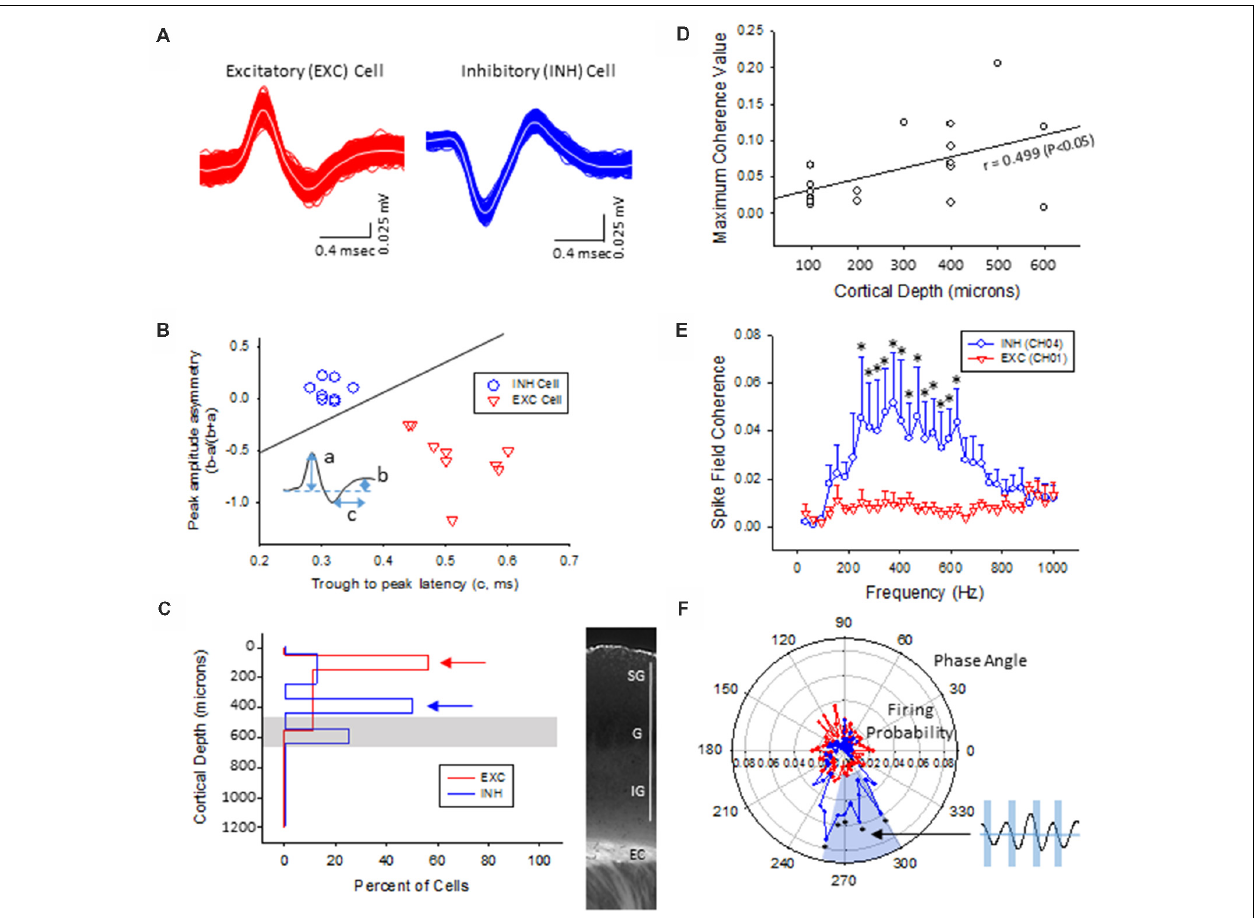
FIGURE 8 | Inhibitory cells from the lower supragranular layer were phase-locked to HFR oscillations in the malformed cortex of freeze lesion animals. (A) Spike sorting of a putative excitatory (red) and inhibitory (blue) cell, based on the associated waveform of each spike. White line in each trace represents the average of the multiple overlapping traces shown in color. (B) Three parameters were calculated from the average trace of each spike waveform (a–c as indicated from inset) to extract features used to classify neurons as either excitatory or inhibitory. Solid line represents the cutoff used to classify excitatory vs. inhibitory cells (Reyes-Puerta et al., 2016). (C) Distribution of isolated single-units across cortical depth. Value of 0 = cortical surface. Arrows indicate the cortical level that expressed the maximal number of excitatory vs. inhibitory neurons. Gray bar indicates level of the granular layer. Representative section of the S1 cortex is shown in the right panel for comparison. White bar = 1,000 µ m. EC, external capsule. (D) Pearson’s correlation between maximum spike field coherence (SFC) values and cortical depth. (E) Average SFC values between excitatory (CH01, n = 5) and inhibitory cells (CH04, n = 4) across frequency bin. ∗ P < 0.05, Holm-Sidak post hoc analysis between groups. (F) Polar plot of average firing probability of excitatory (CH01, n = 5, red) and inhibitory (CH04, n = 4, blue) units across phase angle of the HFR spectrum (300–800 Hz). Inhibitory cells indicated phase-locked responses (blue shaded region) to the downward phase of the corresponding ripple wave (i.e., see inset). ∗ P < 0.05, Holm-Sidak post hoc analysis between